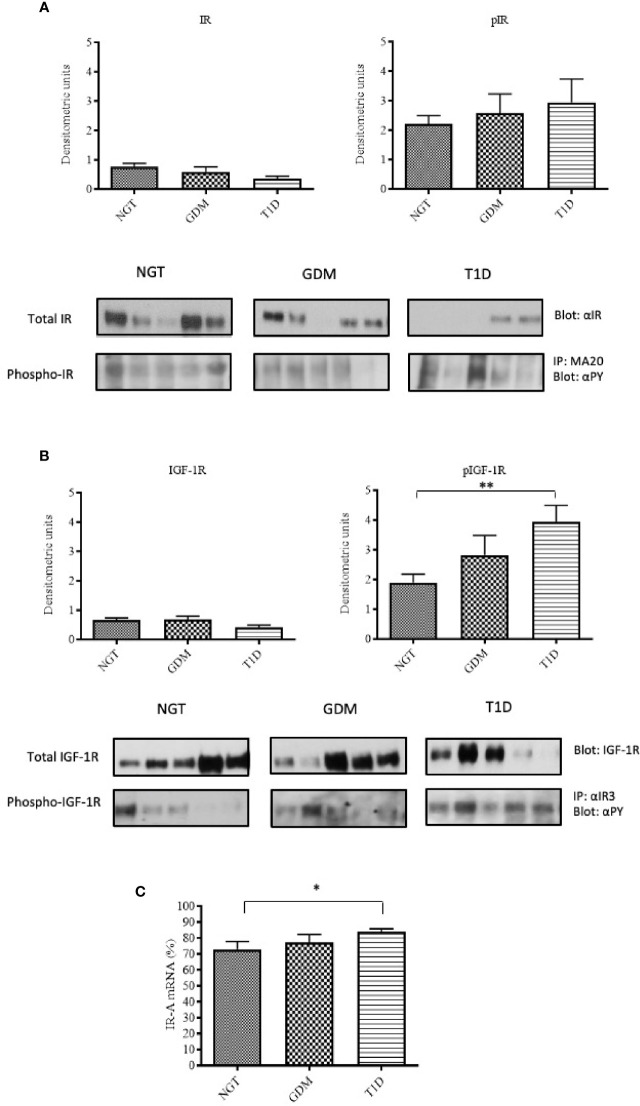
IR and IGF-1R content and phosphorylation in placental tissues. Insulin receptor protein content was detected by immunoblotting with a polyclonal anti-insulin receptor β-subunit. (A) The protein content of IGF-1R in placenta samples was detected by immunoblotting using a polyclonal anti-IGF-1R β-subunit. (B) Solubilized placental tissues were subjected to immunoprecipitation with an anti-IR or anti IGF-1R. The resulting immune complexes were resolved by SDS-PAGE and immunoblotting with an anti-PY antibody to detect receptor phosphorylation (A, B). Protein content was normalized against β-actin, whereas phosphorylated proteins were normalized against their total amount. Each bar represents mean ± SE of all placental samples (n=40 for NGT, n=20 for GDM and n=20 for T1D). A representative Western-blot is included in the bottom (five different patients for each group). IR-A mRNA expression in placental tissue measured by RT-PCR. The bar graphs show the quantitation of IR-A mRNA (mean ± SE) in all samples for each group (C). *p < 0.05; **p < 0.001, after adjusting, in multivariate logistic regression models, for age, pre-pregnancy BMI, gestational age at delivery and type of delivery.